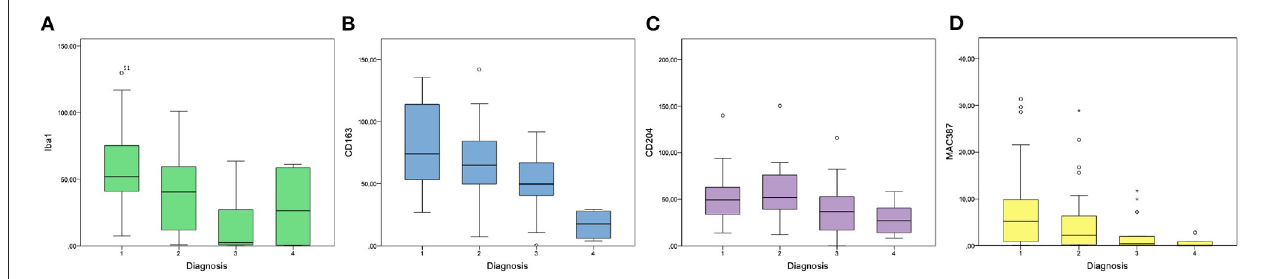
FIGURE 2 | Graphics showing the results of intratumoral Iba1 (A) , CD163 (B) , CD204 (C) , and MAC387 (D) cell counts in the four groups of diagnosis (1: oral melanoma; 2: cutaneous melanoma; 3: cutaneous melanocytoma; 4: oral